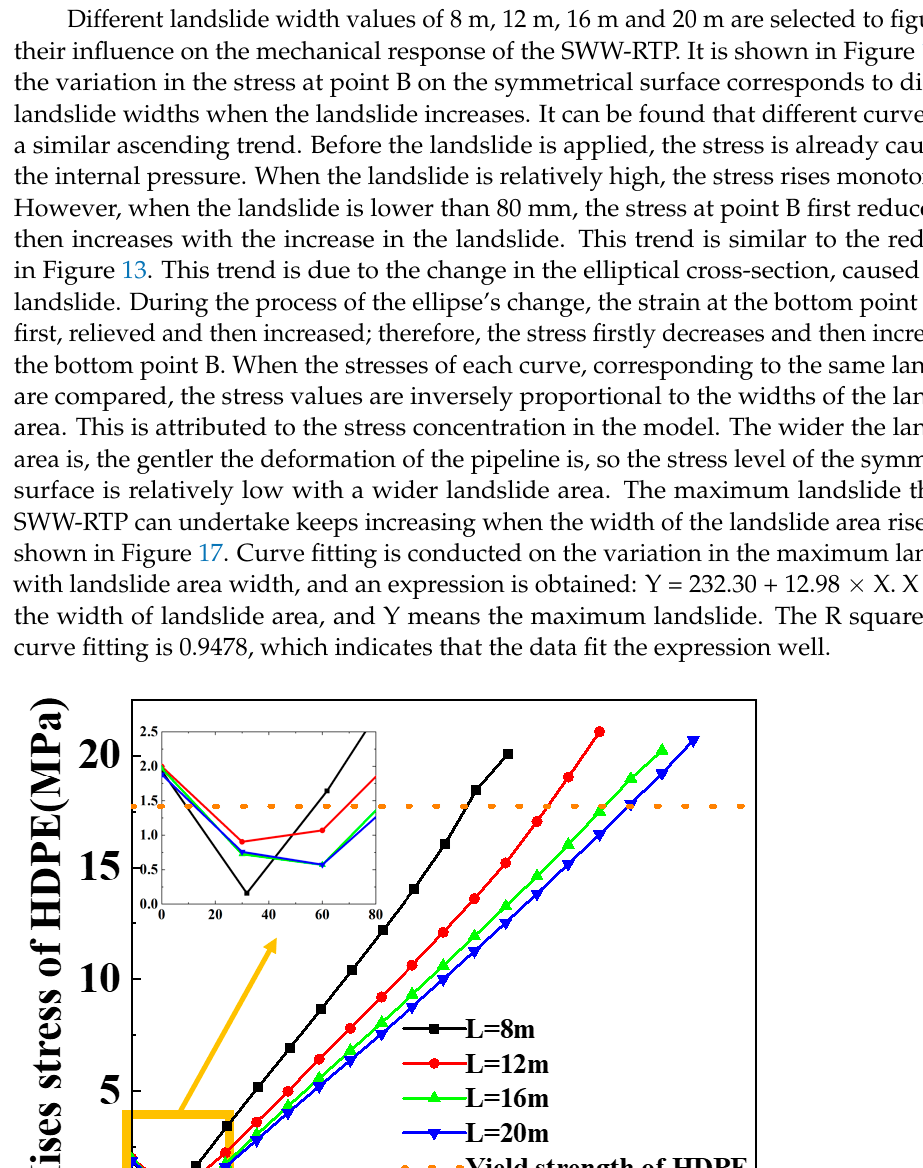
Figure 17. Variation in maximum landslide of the SWW-RTP with different soil widths. As mentioned above, the main possible failure modes of the SWW-RTP pipe defor- mation are the axial-bending deformation of the SWW-RTP and the flattening defor- mation of its cross-section. The maximum curvature α is always found on the symmetrical surface of the SWW-RTP, which can represent the extent of the bending deformation, and the ovality δ can characterize the extent of the cross-section’s distortion. In this section, the variations in the α and δ , with different widths of landslide area, are illustrated in Figures 18 and 19, and this can help discriminate the critical factor causing the SWW-RTP failure. As for the SWW-RTP–soil model, with a constant width of landslide area, the in- crease in the landslide results in an increase in the maximum curvature α and the ovality δ . Meanwhile, the variation in the width of the landslide area leads to different trends in the α and the δ . As is shown in Figures 20 and 21, when the width of the landslide area increases, α declines almost linearly, but δ keeps nearly stable at 0.12. Curve fitting is car- ried out to find the relationship between the α and the width, which is α = − 3.50789 − 0.08195 * X. X indicates the width. The R square of the curve fitting is 0.9823. According to the expression, the maximum curvature α of the pipeline can be determined conven- iently instead of via complicated numerical simulations. This can be very helpful for the safety assessment of the pipeline under landslide conditions. Different trends in the α and